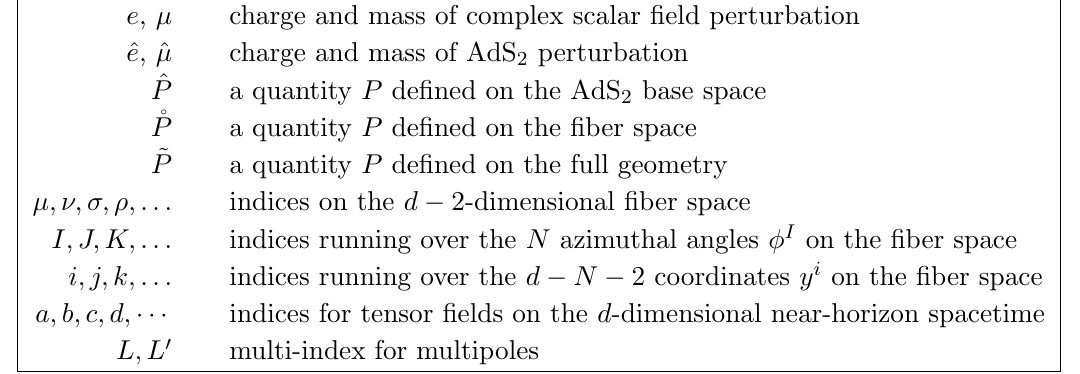
Table 1 . Table of